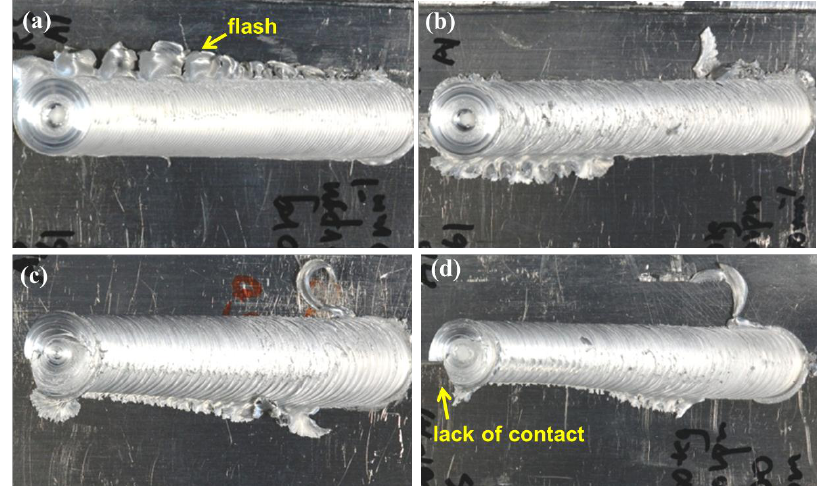
Figure 3. Photo showing the appearance of the dissimilar FSW joints with UFGed 1050Al on the RS side and 6061-T6 on the AS produced at a revolutionary pitch of ( a ) 0.5; ( b ) 0.75; ( c ) 1; and ( d ) 1.25 mm/rev.